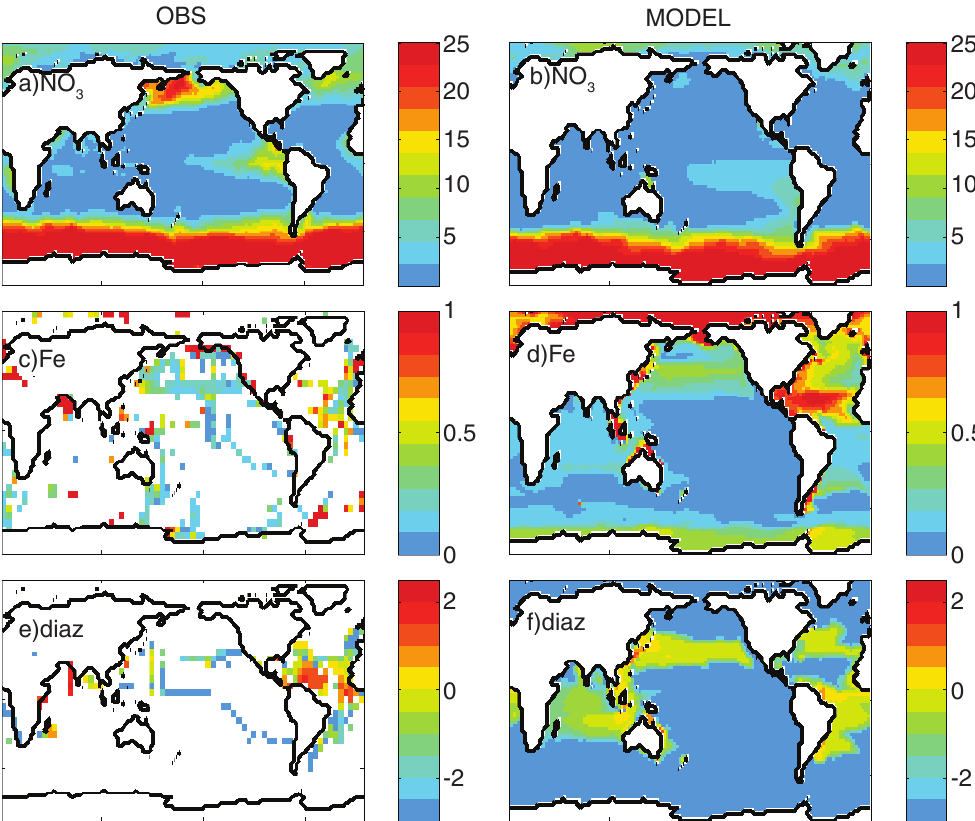
Figure 1. Observations and model over top 50m: (a) World Ocean Atlas (Garcia et al., 2006) annual mean nitrate (mmolm − 3 ); (b) model pre-industrial annual mean nitrate (mmolm − 3 ); (c) composite of all iron measurement in top 50m (nmolm − 3 ) from compilation of Tagliabue et al. (2012); (d) model pre-industrial annual mean iron (mmolm − 3 ); (e) composite of all diazotroph biomass measurement (logmgCm − 3 ) from compilation of Luo et al. (2012); (f) model pre-industrial annual mean diazotroph biomass (logmgCm − 3 ). Note that composites in (c) and (e) are made with all available data without regard to date, so do not represent annual